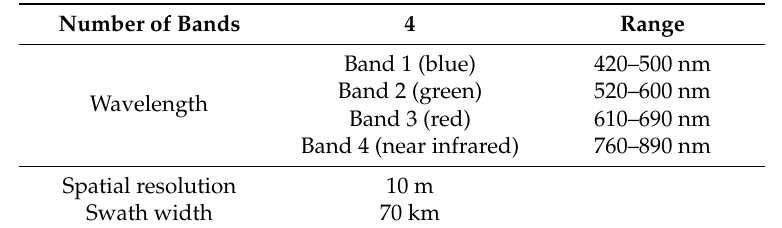
Table 1. Technical specifications of ALOS.